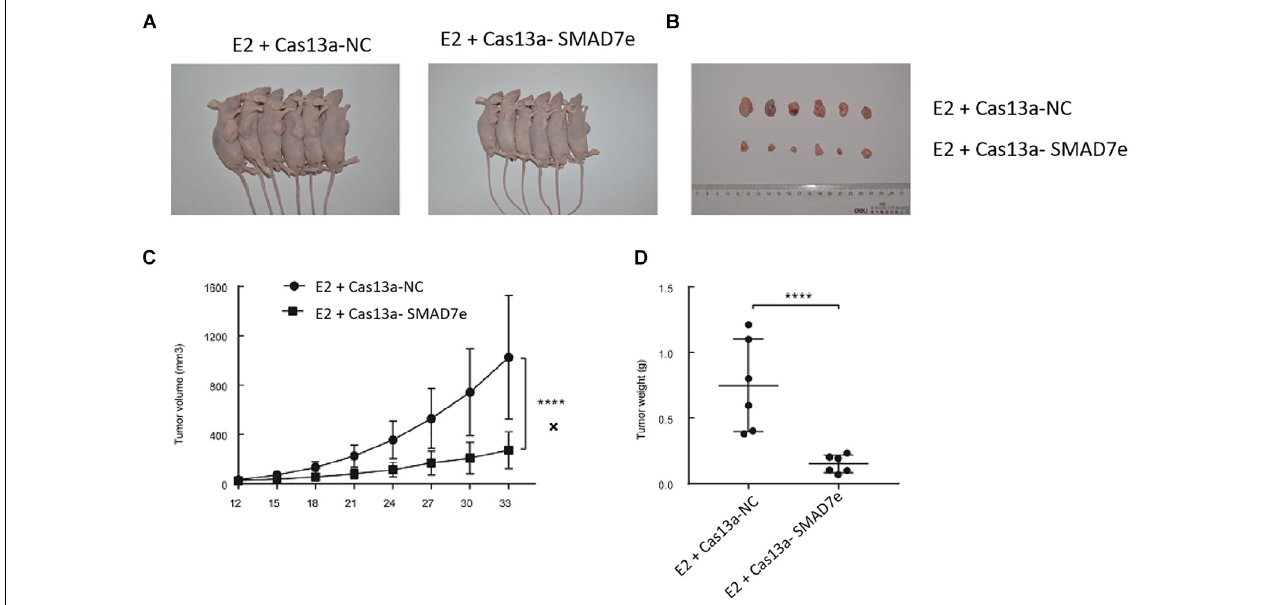
FIGURE 5 | The effect of Cas13a-SMAD7e on the in vivo growth of E2-treated bladder cancer cells. (A) Representative images of xenograft models. (B) Xenograft tumors from respective groups were shown after injection with SMAD7e stable knockdown T24 cells and vector transfected T24 cells. (C) Tumor growth curves were measured every 3 days. (D) Average weight of excised tumors. **** p <